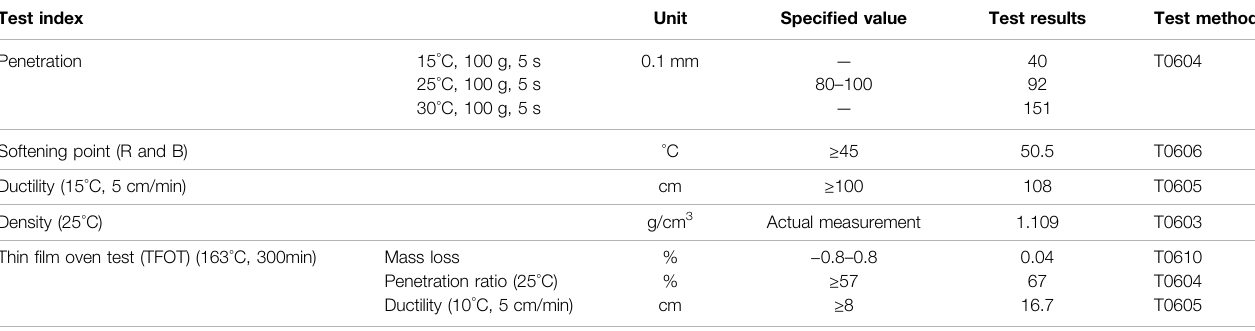
TABLE.1 | Technical indexes of 90# base asphalt.